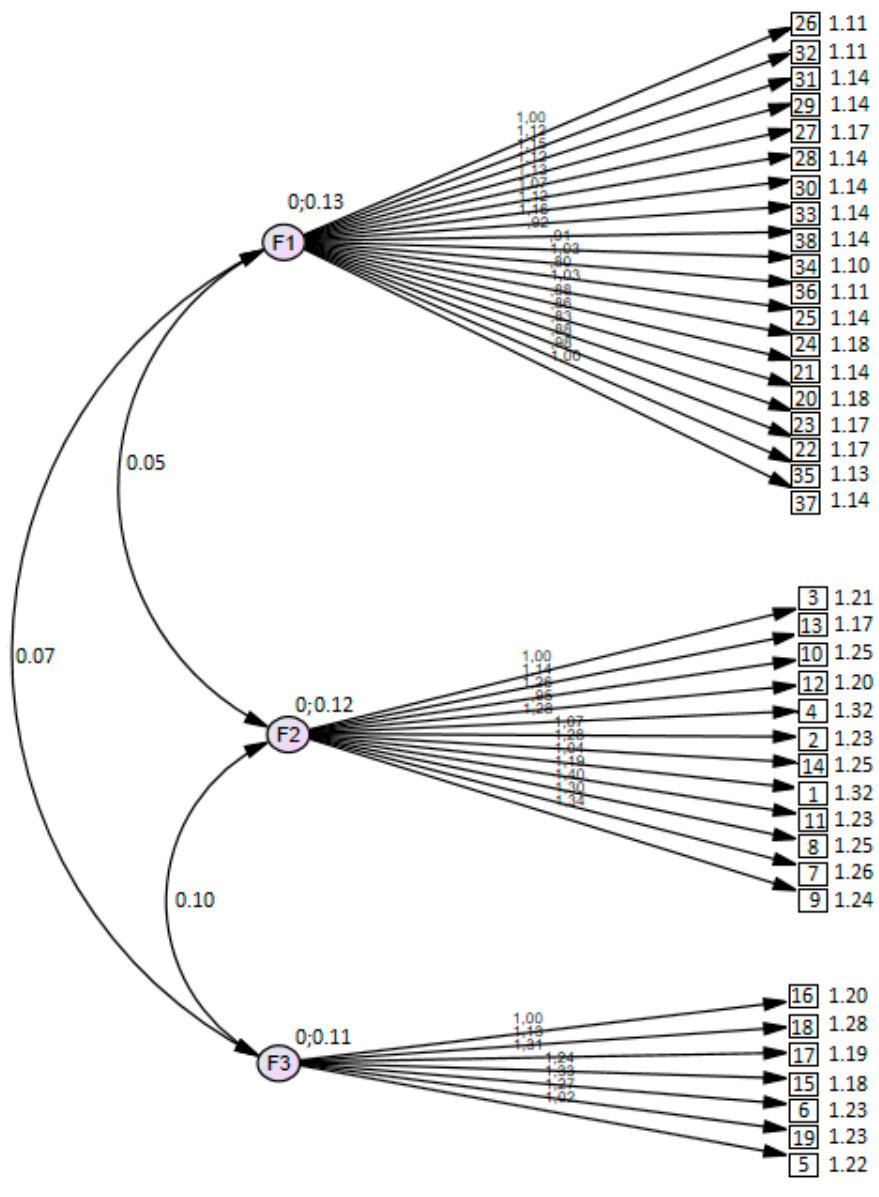
Figure 1. Confirmatory Factor Analysis Diagram.